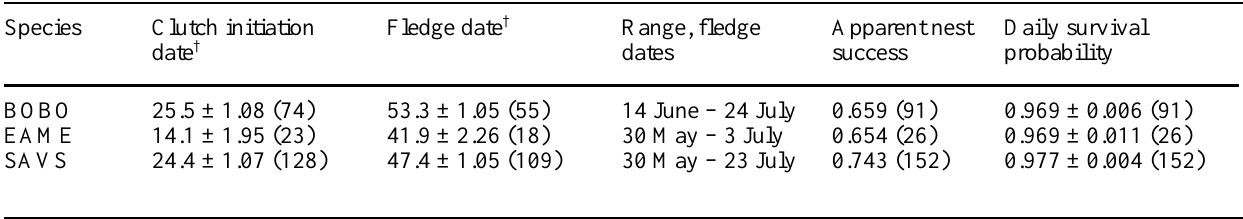
Table 1. Breeding biology data for obligate grassland breeding birds at Iroquois National Wildlife Refuge, 1994-2003. Daily survival probabilities were calculated using the Mayfield method. Values are mean ± SE; sample sizes are given in ( ). BOBO = Bobolink, EAME = Eastern Meadowlark, SAVS = Savannah